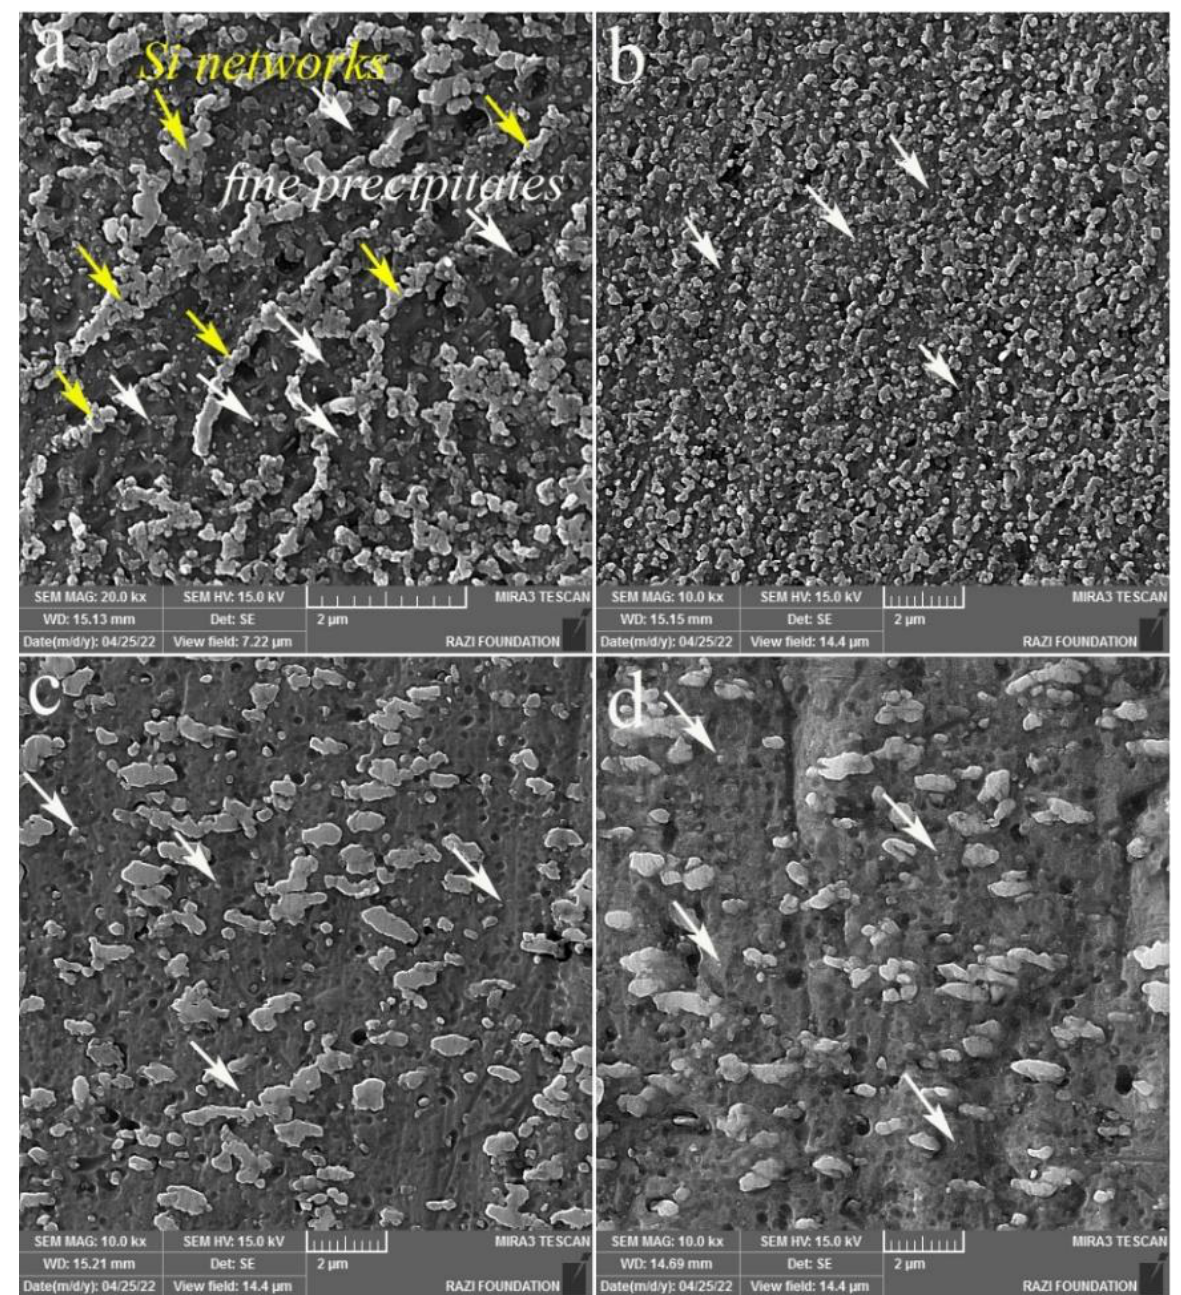
Figure 4. Secondary electron SEM images: ( a ) Si networks in BM, and ( b – d ) Si particles at the center of the SZs (fine SZs) for S1, S2, and S3, respectively. The yellow arrows in ( a ) indicate the fibrous Si networks. The white arrows denote the fine precipitates.